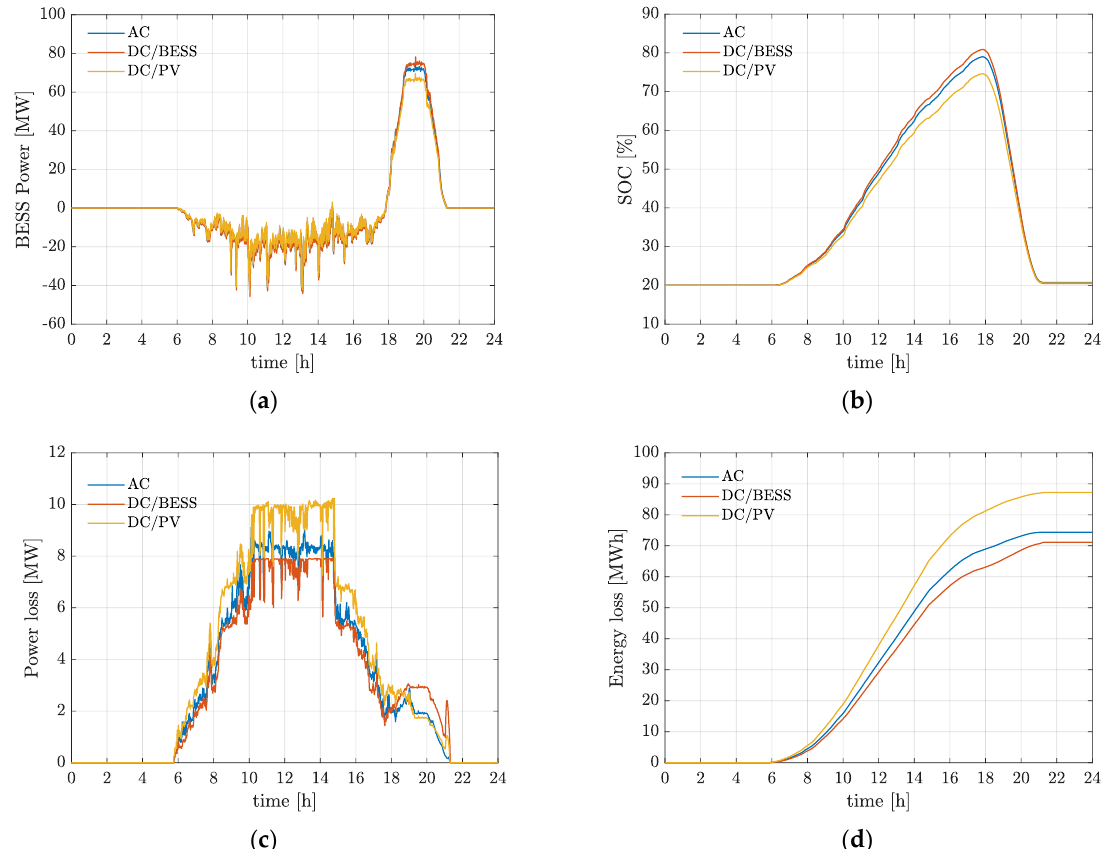
Figure 10. Typical summer day simulation result: ( a ) battery power profiles, ( b ) battery SOC; ( c ) overall system power loss, ( d ) overall system energy loss.